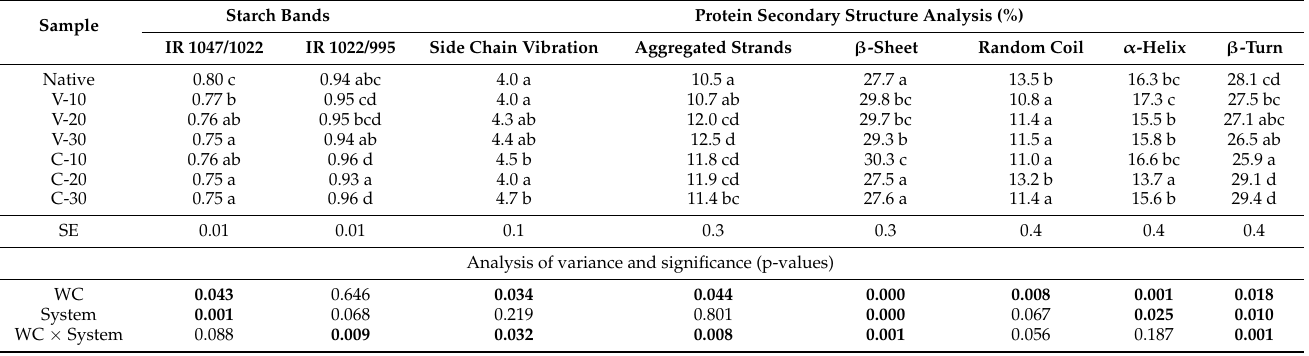
Table 4. Starch bands and protein secondary structure content from FTIR analysis of flour samples obtained from untreated (native) and microwave-treated quinoa